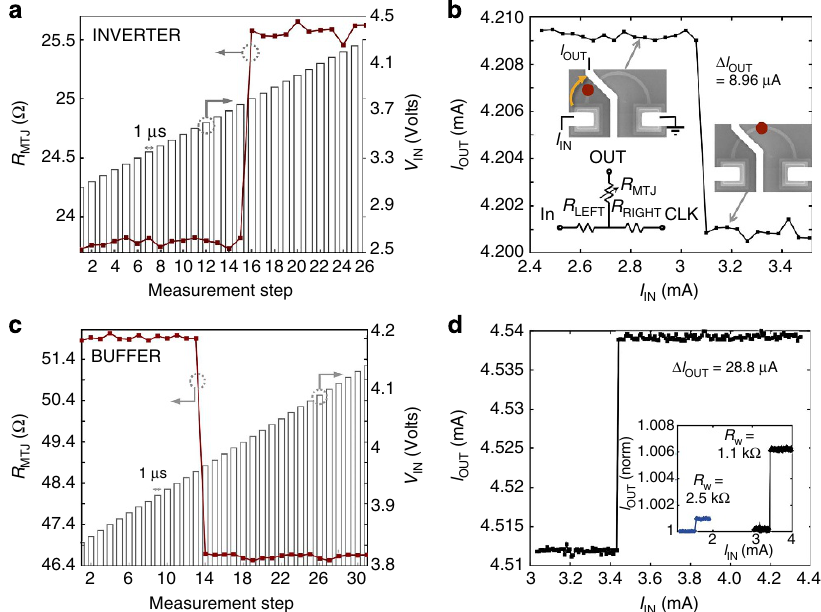
Figure 2 | Inverter and buffer operation. ( a ), Transient showing the MTJ resistance and applied voltage pulses between IN and CLK versus time. At 3.80V, the device switches from low resistance (bit 1) to high resistance (bit 0). ( b ), Transfer characteristic of I OUT through the MTJ versus I IN across the wire. The SEM images show the configuration below I T , with the DW position approximated by the red dot and I IN electron flow direction shown by the yellow arrow, and the approximate DW position after I T . inset, Simple circuit diagram to represent the device, including the wire resistance and the variable tunnel junction resistance. ( c ), Transient behaviour showing a buffer operation, plotting R MTJ and V IN versus measurement step as we increase the 1- m s voltage pulse amplitude in 0.01V steps. This device has similar R w to the previous device, but slightly higher R MTJ and TMR . At 3.97V, the device switches from a high-resistance output to a low-resistance output. ( d ), Transfer characteristic for the buffer. inset, Comparison of this transfer characteristic (right black curve) to that of another device (left blue curve) with less well matched R w and R MTJ